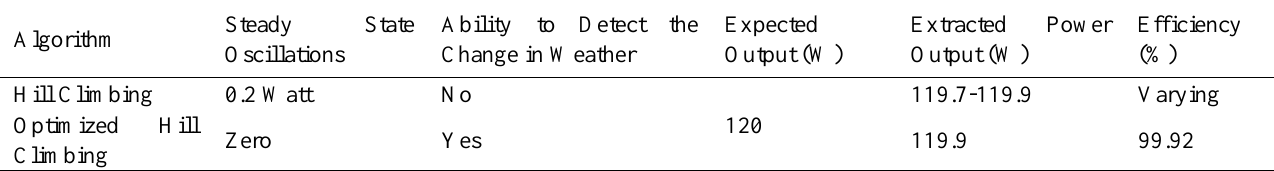
Performance comparison of the conventional and proposed optimized hill climbing